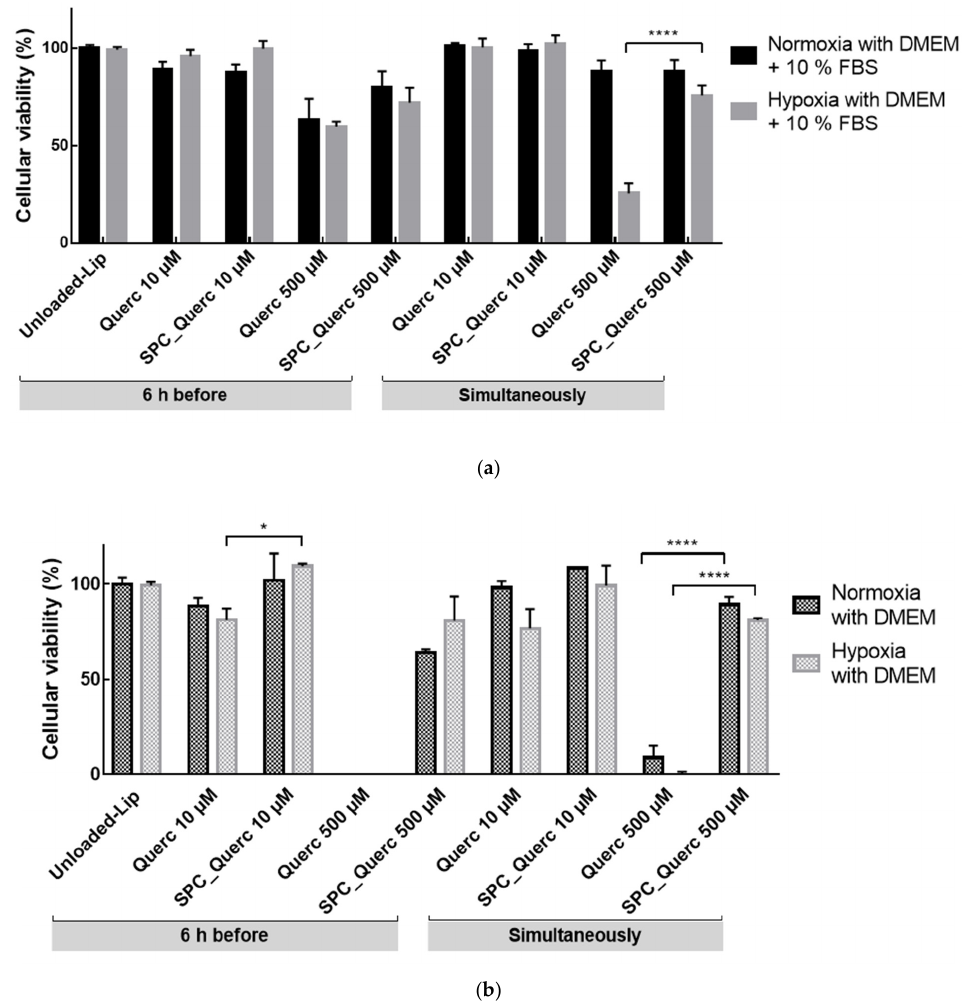
Figure 6. HepG2 cells viability upon incubation with 10 or 500 µM quercetin. Viability was evaluated either with liposomal or free quercetin, under hypoxia or normoxia conditions, in the presence of complete ( a ) or simple ( b ) medium. Unloaded-liposomes (Unloaded-Lip) were used as